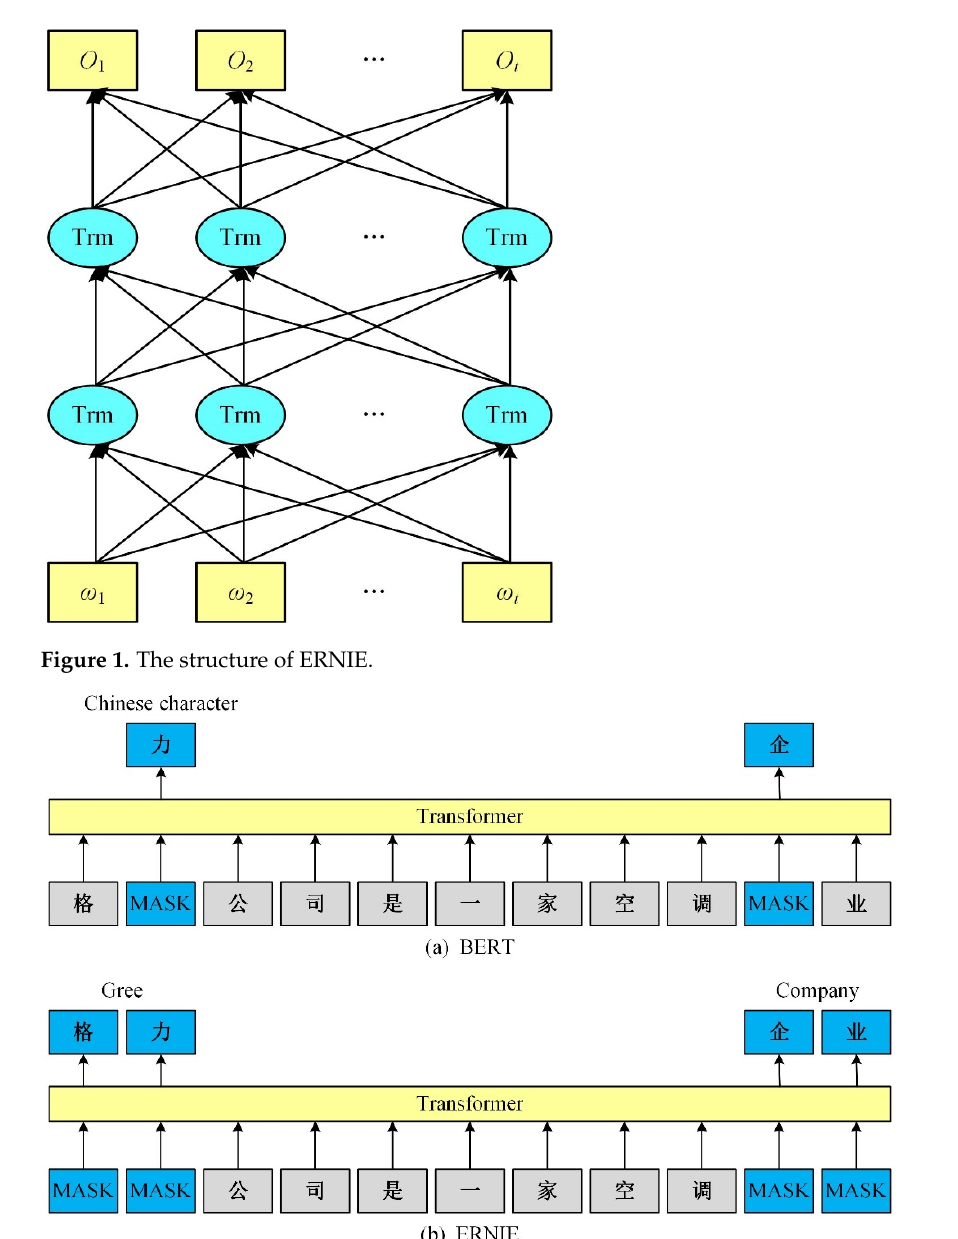
Figure 2. Comparison of BERT and ERNIE masking strategy in Chinese sentence.